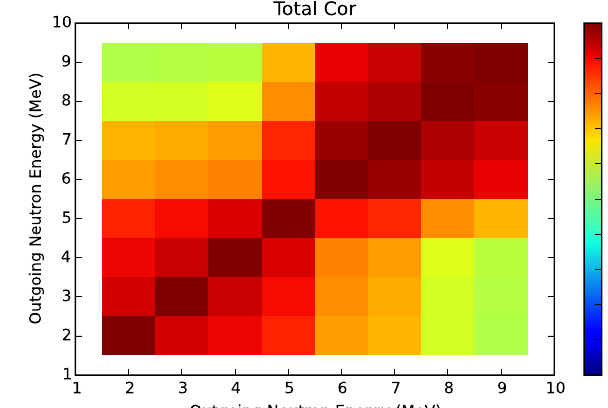
Fig. 5. A plot of the total correlation matrix estimated for Lestone et al. PFNS using ARIADNE with the input deck in Figure 2 is shown as automatically generated by the program.